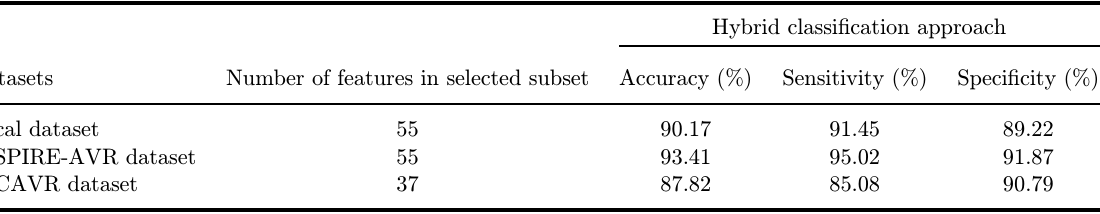
Table 5. Performance of hybrid classi¯cation for feature subsets acquired using PCC method.